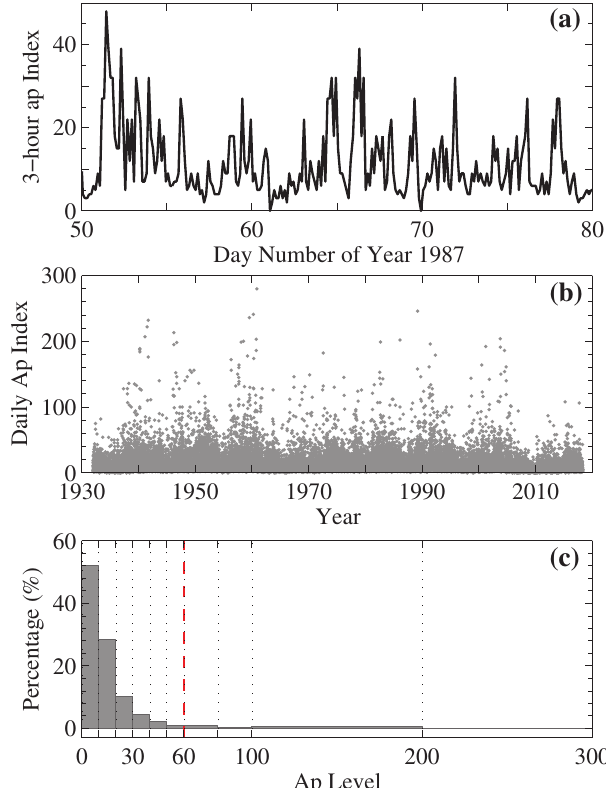
Fig. 1. (a) A segment of the 3-h ap index showing frequent occurrence of weaker geomagnetic activities; (b) time series of the daily Ap index; (c) percentages of different geomagnetic activity levels indicated by Ap